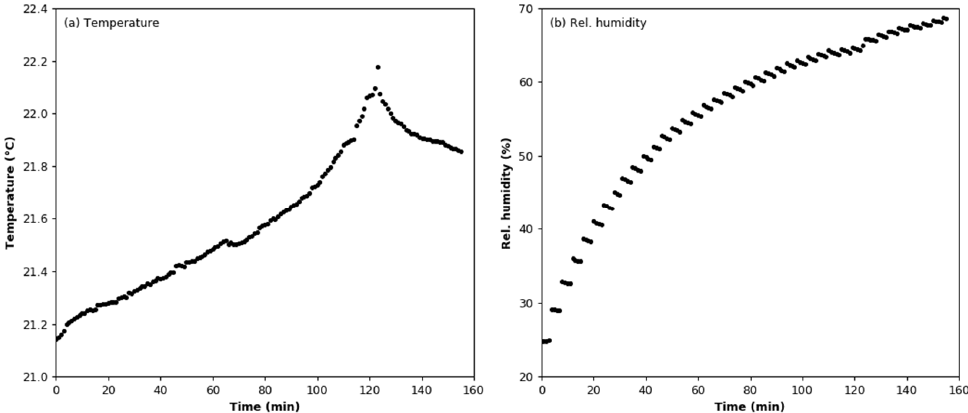
Figure 6. Figure 6. Environmental conditions during the humidity effect test: ( a ) air temperature; ( b ) relative humidity. ( b ) relative humidity.